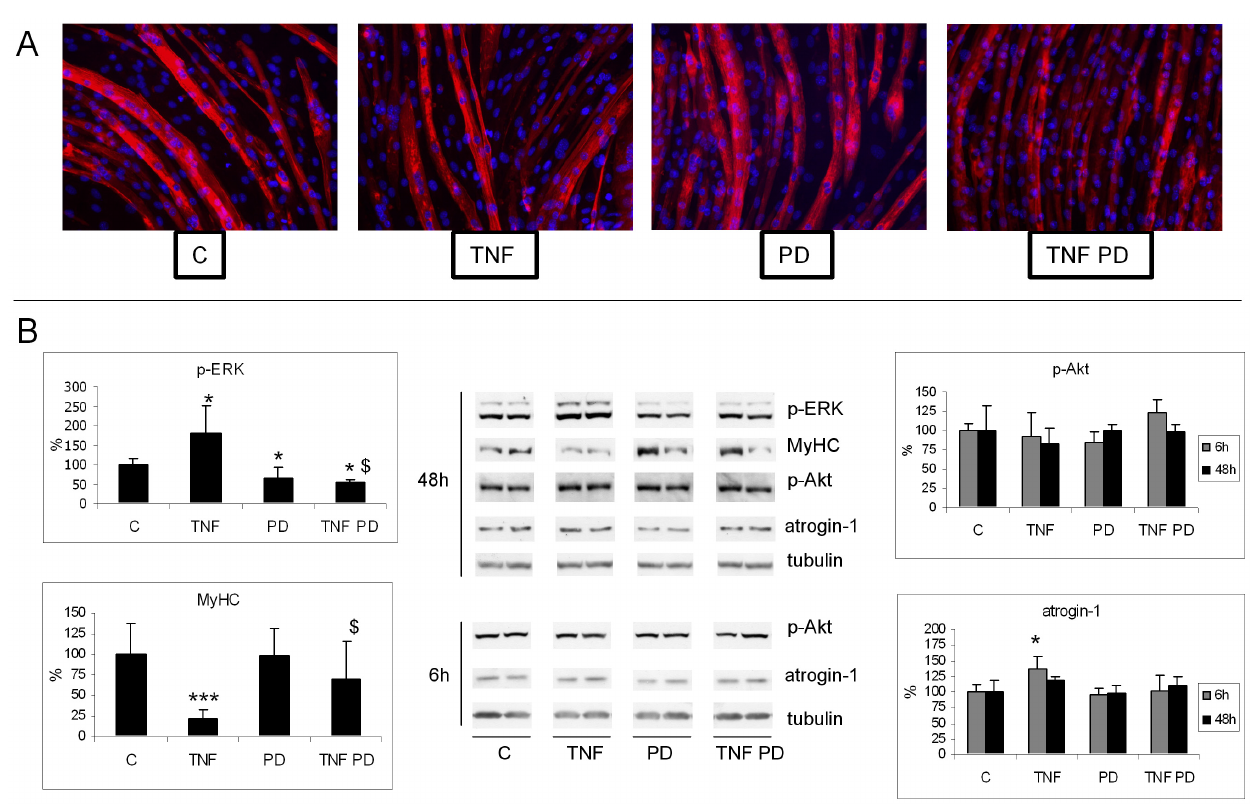
Figure 3. ERK inhibition prevents TNF a -induced alterations in C2C12 myotube cultures. C2C12 myotubes (5 days differentiation) treated for 48 h with 100 ng/ml TNF a , in the presence or in the absence of PD (20 m M). (A) MyHC immunostaining (red: MyHC; blue: nuclei). (B) Protein expression levels of p-ERK, MyHC, p-Akt and atrogin-1, the latter two evaluated at both 6 and 48 h (see Li et al., 2005). Densitometric quantifications were normalized according to tubulin levels. Data (means 6 SD; n=3) expressed as percentages of controls. Significance of the differences: *p , 0.05 vs C; $ p , 0.05 vs TNF a .